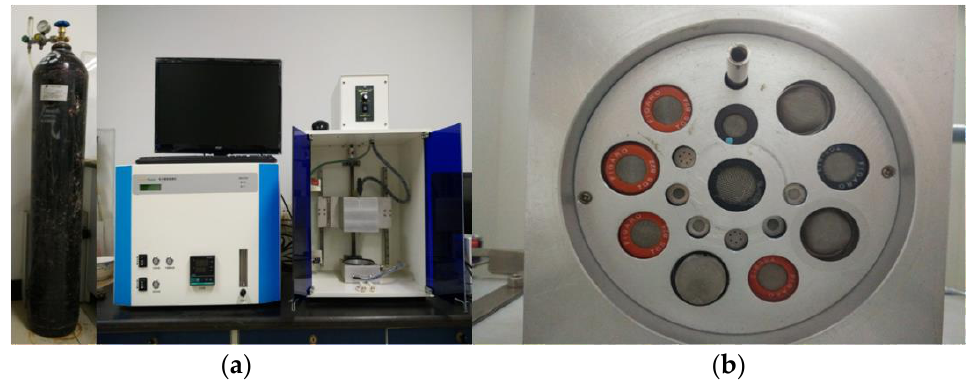
Figure 1. Electronic nose device ( a ) and gas sensor distribution ( b ).